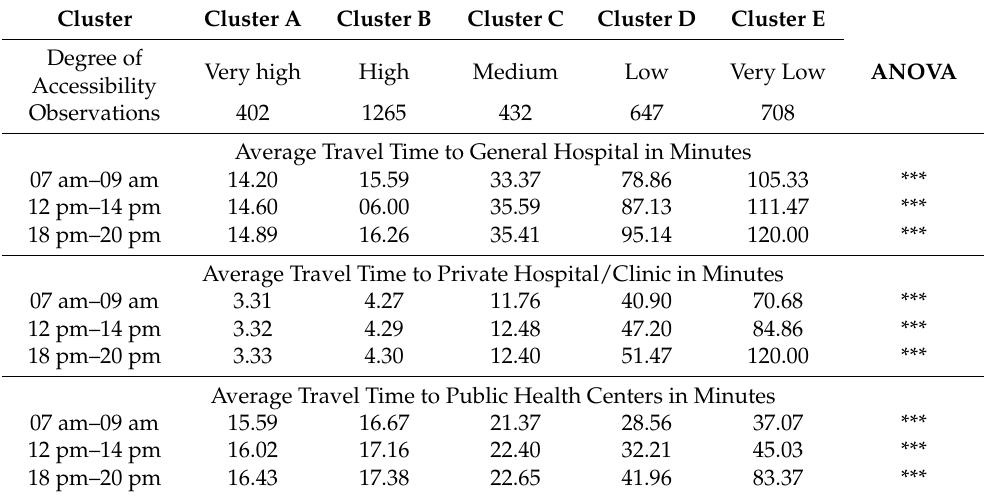
Table 5. Average Travel Time to Healthcare Services by Public Transportation between 5